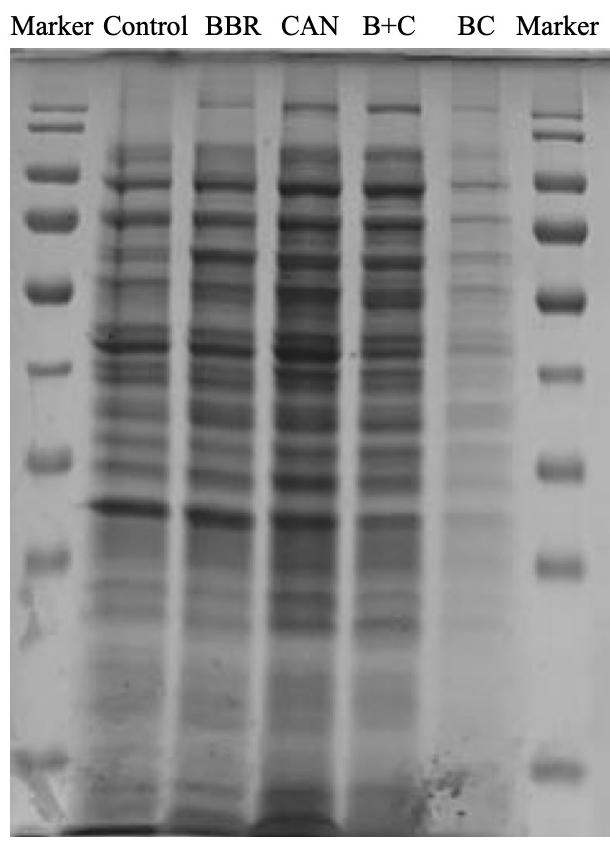
Figure 7. SDS-PAGE analysis of intracellular soluble proteins of Pseudomonas aeruginosa treated with BC of 0.1 mM for 24 h.